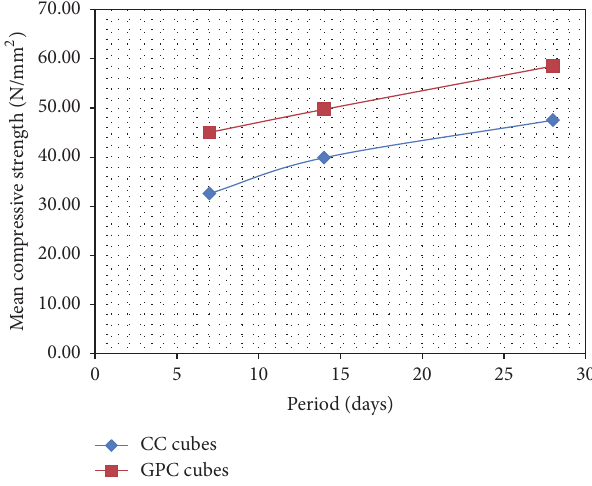
Figure 1: Compressive strength